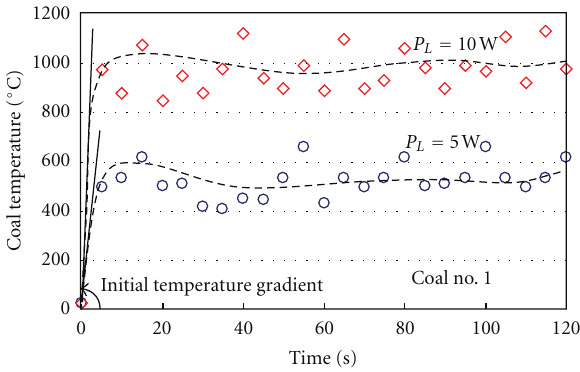
Figure 6: Coal sample no. 1: temperature versus time.